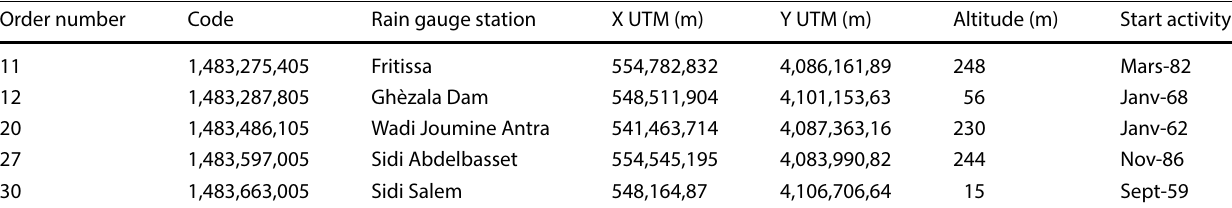
Table 3 Rain gauge stations with geographical coordinates located in Ichkeul lake basin Order number